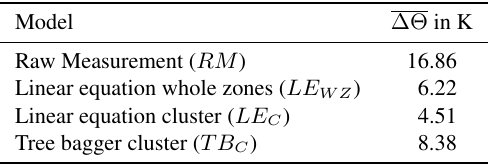
Table 1. Maximum average frame-to-frame temperature